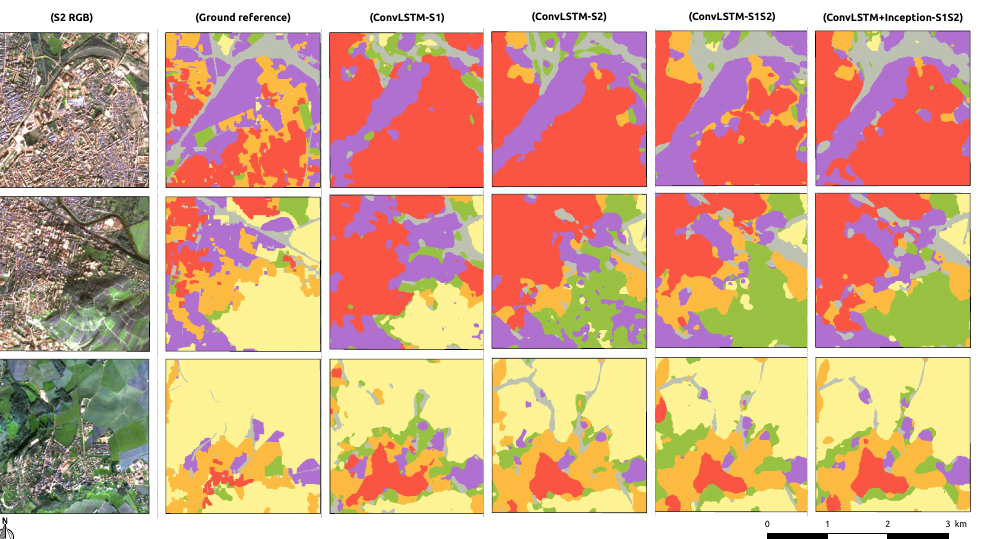
Figure 8. Results for each method for 6 semantic classes (Legend is available in Table